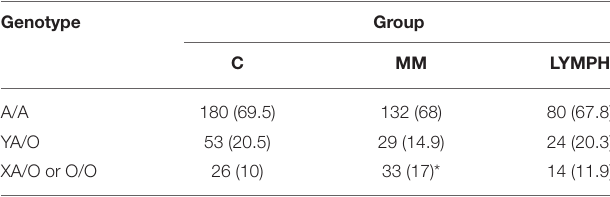
TABLE 2 | Frequency of MBL2 genotypes (SNP located within promoter and exon 1) within major groups.